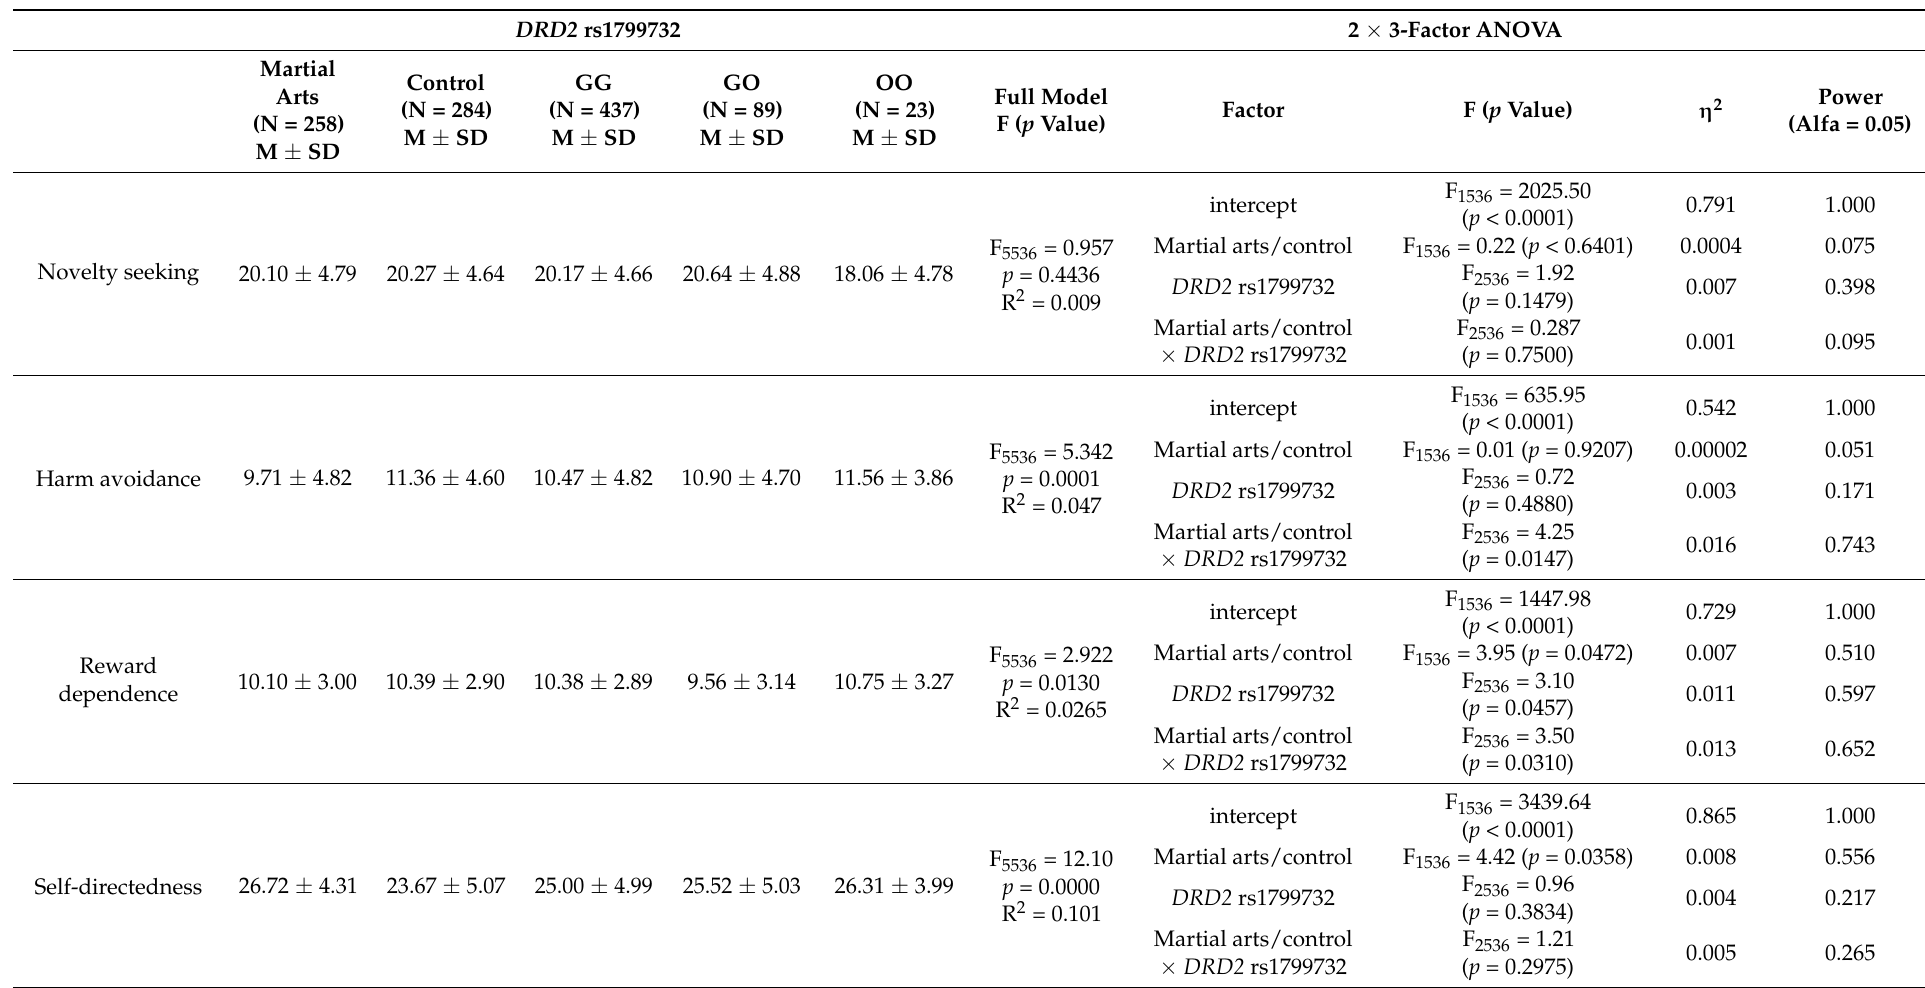
Table 4. The results of 2 × 3 factorial ANOVA for martial arts subjects and controls, incorporating novelty seeking, harm avoidance, reward dependence, self-directedness, cooperation, self-transcendence results, and DRD2 rs1799732 (manual)